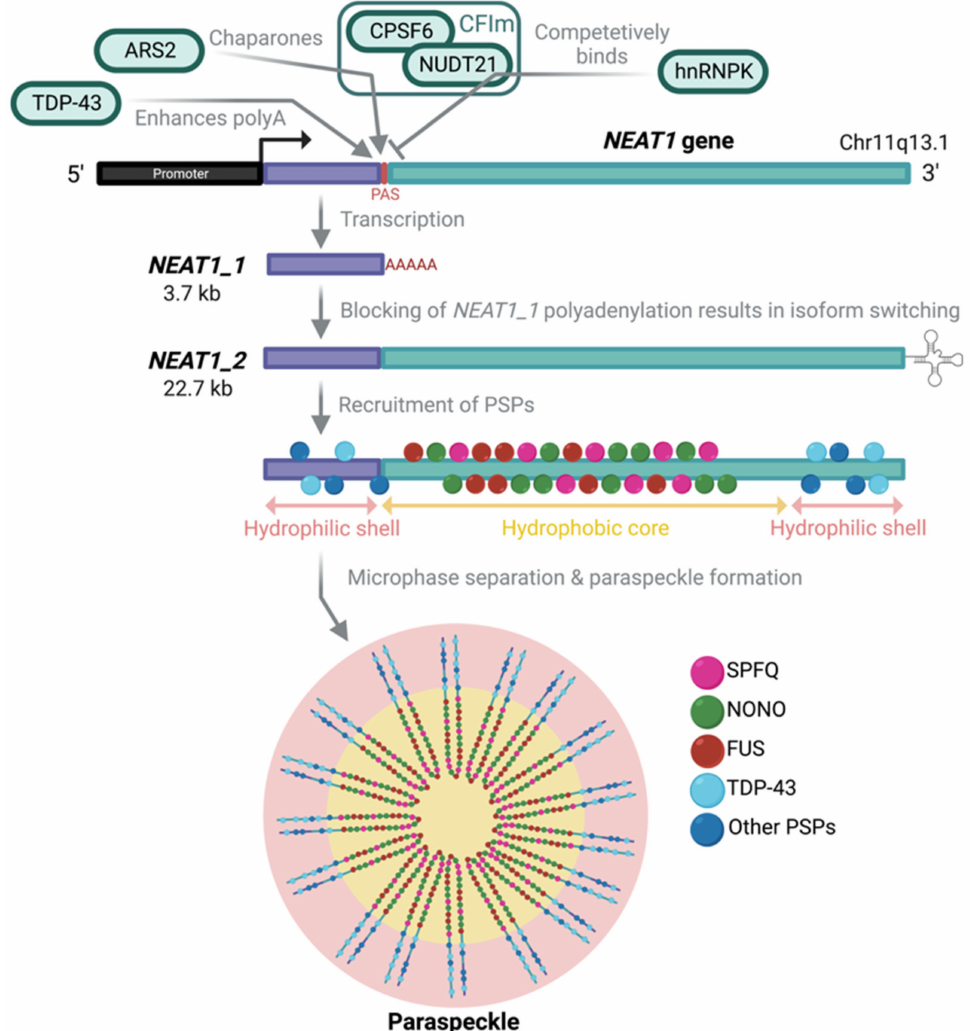
Figure 1. The NEAT1 gene gives rise to two isoforms with identical 5 (cid:48) sequences. The paraspeckle- independent NEAT1_1 undergoes canonical 3 (cid:48) polyadenylation whilst the blocking of 3 (cid:48) polyadeny- lation via competitive binding of hnRNPK to the CFIm complex yields the paraspeckle-essential NEAT1_2 . The recruitment of paraspeckle proteins to the hydrophilic and hydrophobic regions of NEAT1_2 leads to phase-separated